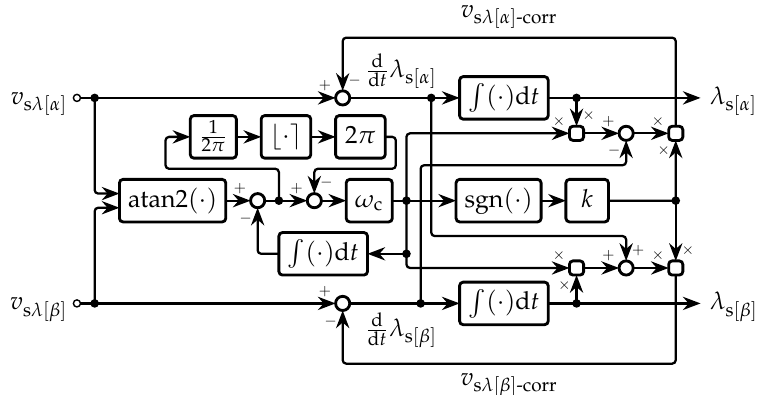
Figure 4. A diagram of the proposed compensation of the